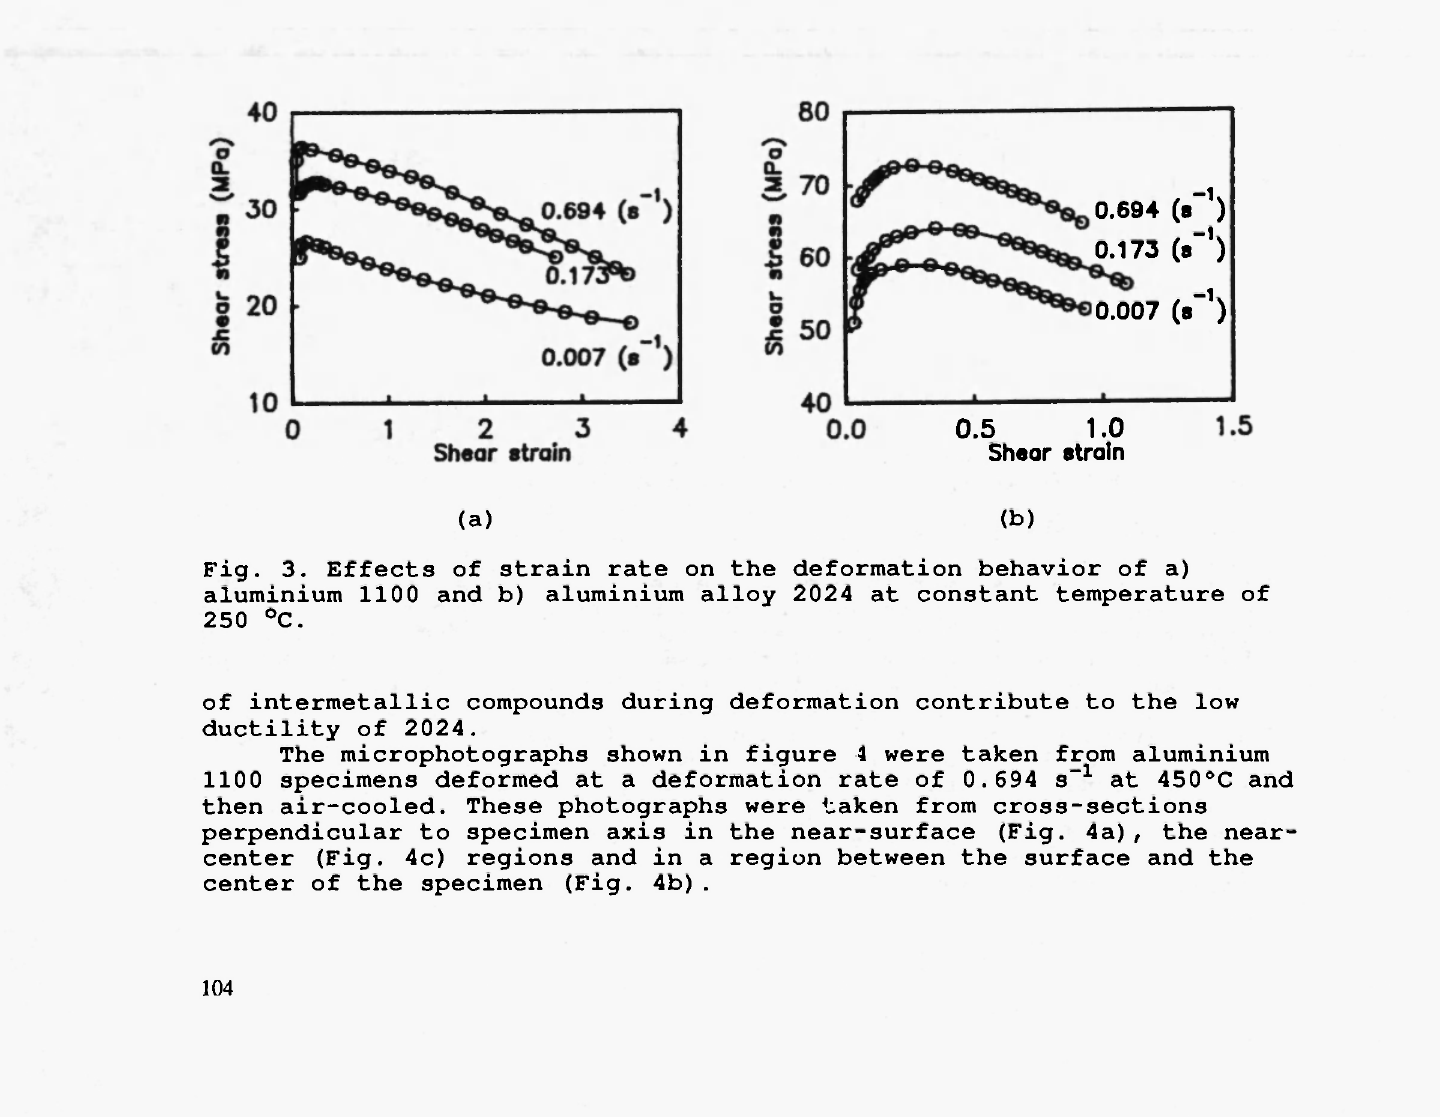
Fig. 2. Effects of temperature on the shear stress of a) aluminum 1100 b) aluminium alloy 2024 at constant shear strain rate of 3.5xl0~ 2 s" 1 .